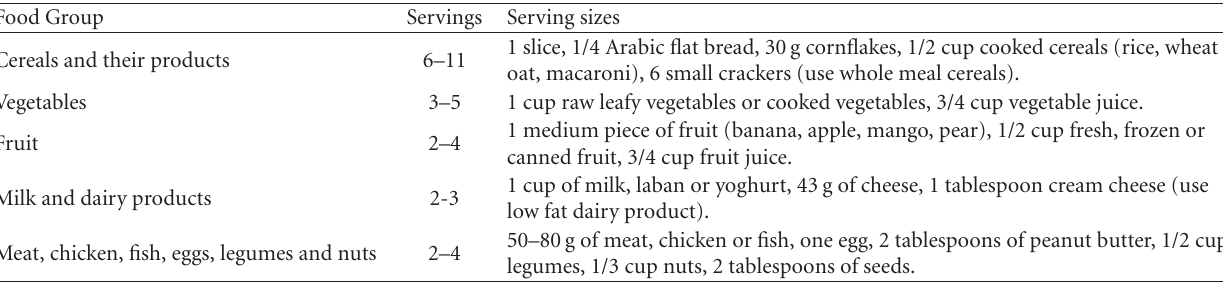
Table 1: Food groups and suggested daily